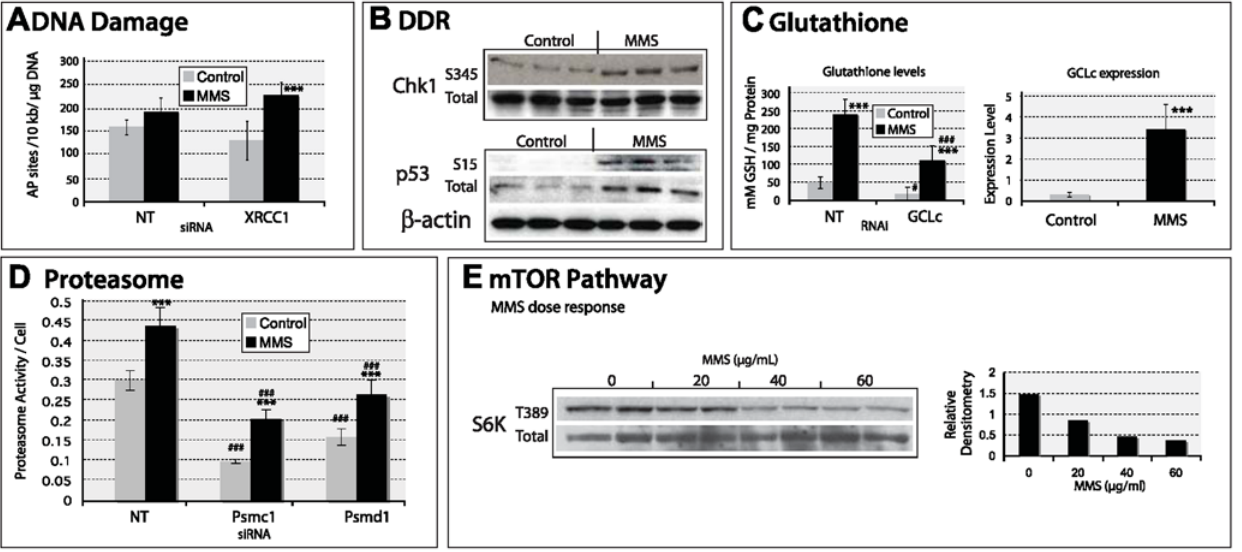
Figure 5. Functional conservation in mouse embryonic fibroblasts of five pathways found to be utilized for MMS survival in Drosophila cells. (A) MMS exposure results in an increase in AP sites, siRNA based XRCC1 knock-down results in an increased quantity of AP sites following MMS exposure. (B) MMS exposure results in phosphorylation of CHK1 and p53 and in an accumulation of total p53 levels. (C) MMS exposure results in an increased amount of total glutathione and this increase is partially dependent upon GCLc. The intracellular glutathione concentration is expressed as mmoles/L normalized per mg protein. This GCLc dependency correlates with the increased level of GCLc expression observed following MMS exposure. (D) Proteasome activity is increased following MMS exposure in a manner that is dependent upon proteasome components Pmsc1 and Psmd1. Proteasome activity is expressed as units of activity/cell, normalizing the activity to the number of cells using a parallel viability assessment. (E) MMS exposure results in a dose-dependent decrease in the phosphorylation of p70S6K. Statistically significant differences between unexposed and MMS exposed cells are denoted (*; **; ***; with p-values of , 0.05; , 0.01; and , 0.001 respectively) as are differences between NT control and each siRNA knock-down ( # ; ## ; ### ; with p-values of , 0.05; , 0.01; and , 0.001 respectively).